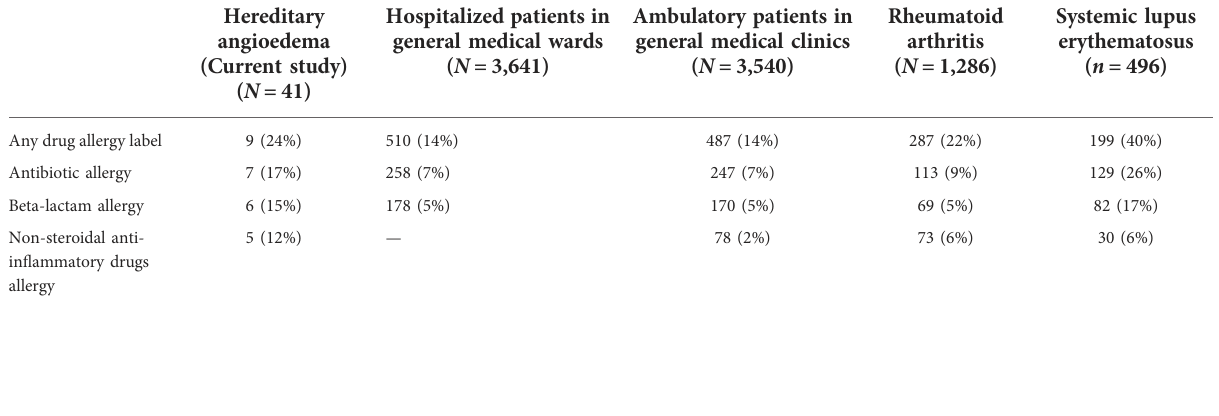
TABLE 2 Comparison of the prevalence of various drug allergy labels among different patient cohorts in Hong Kong.